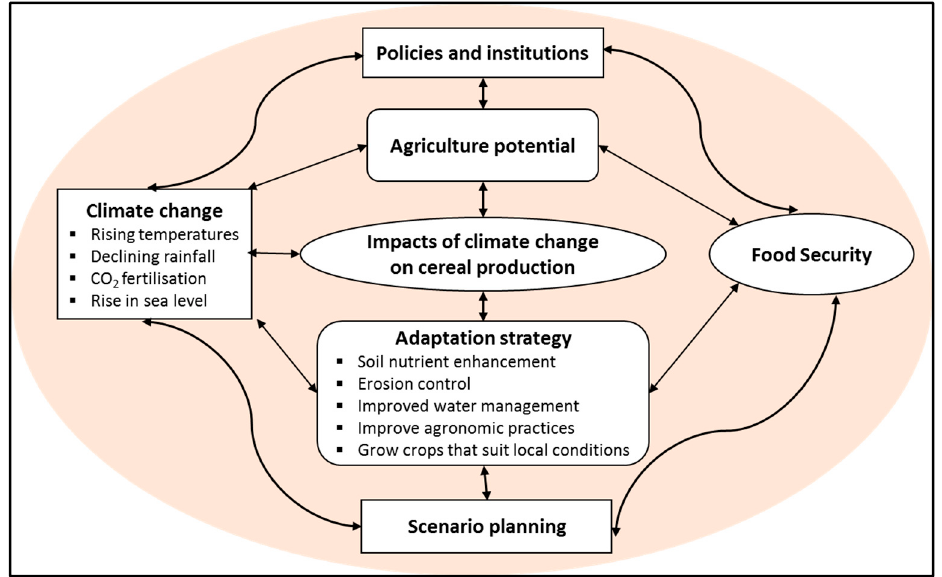
Figure 2. Methodological flowchart for climate change, cereal yield and food security. Source: Developed by authors.